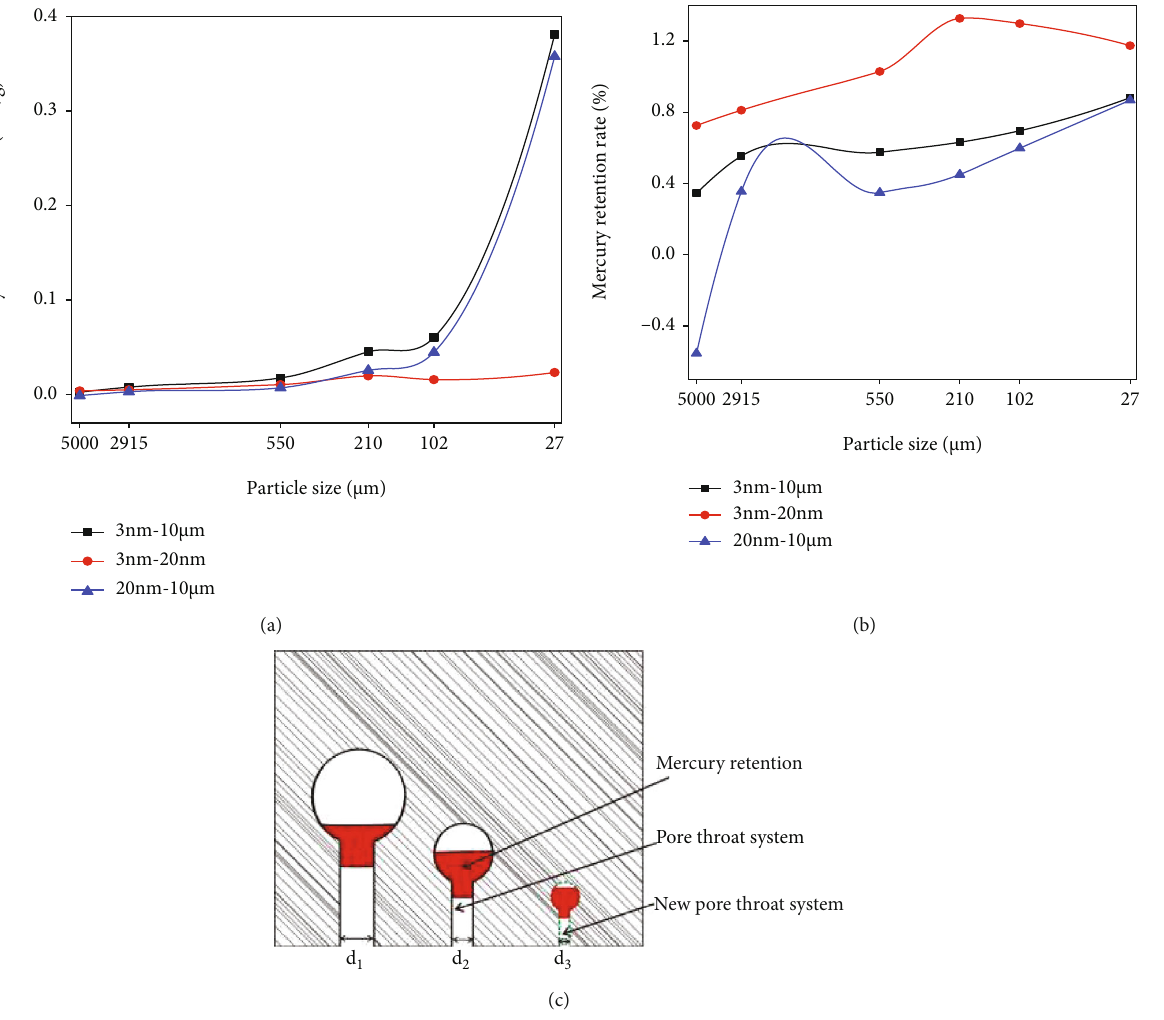
Figure 7: E ff ect of particle size and pore size on mercury retention. (a) The relationship between mercury retention volume and shale particle size. (b) The relationship between mercury retention rate and shale particle size. (c) Schematic diagram of mercury retention within di ff erent pore-throat